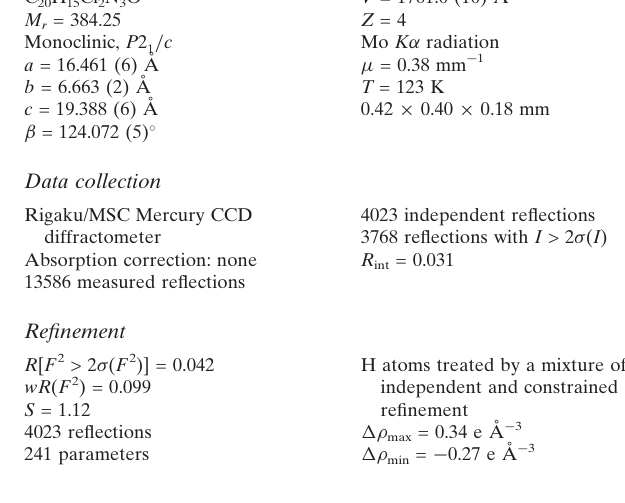
Hydrogen-bond geometry (A˚ , (cid:3) ).